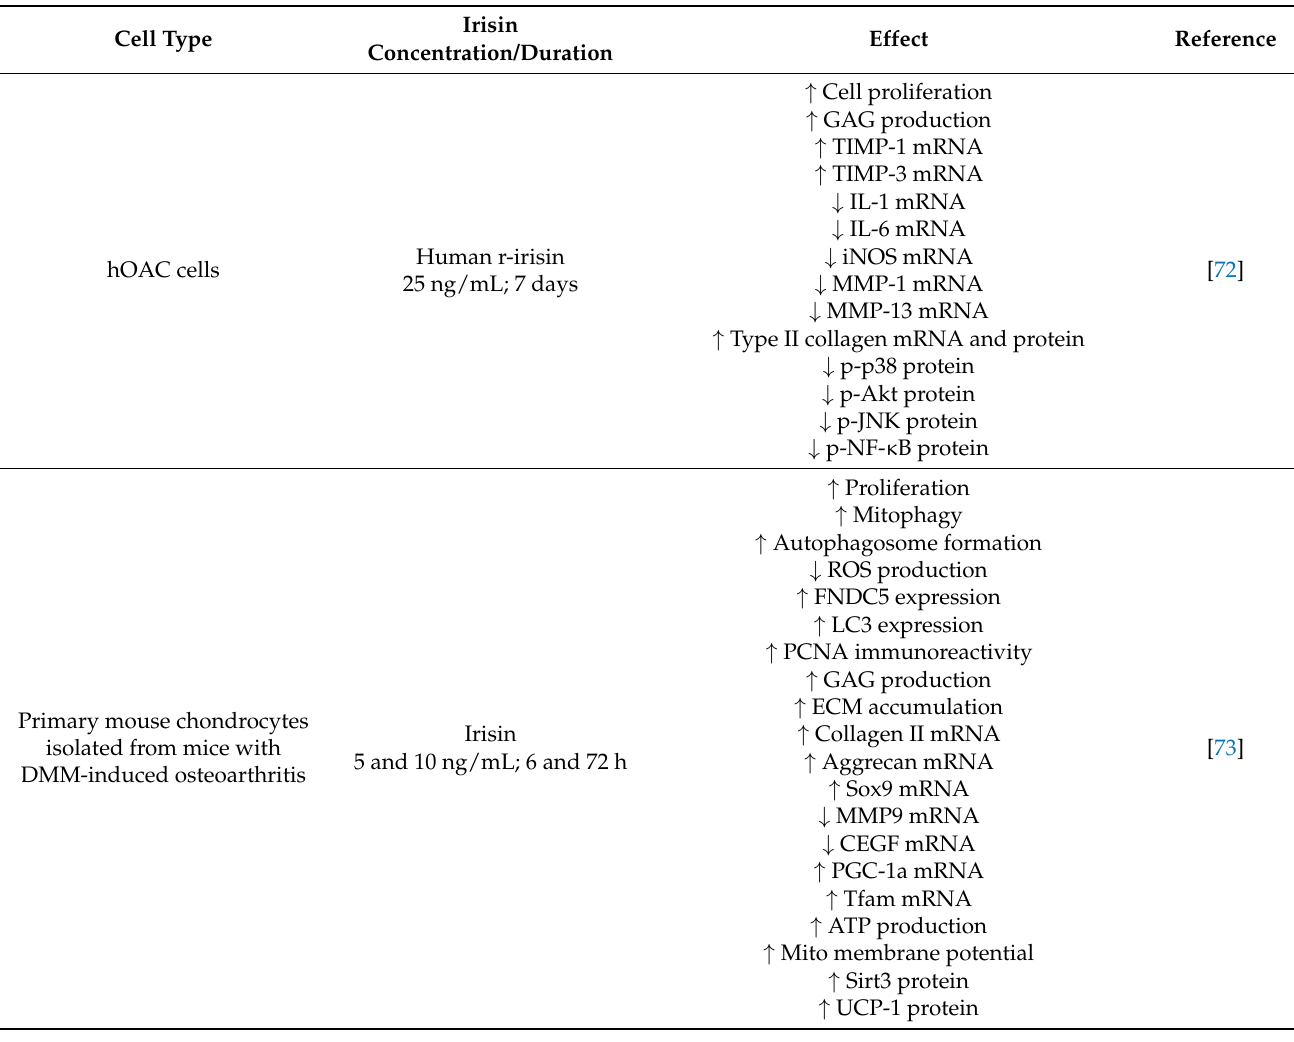
Table 4. Role of Irisin on Chondrocytes: in vitro